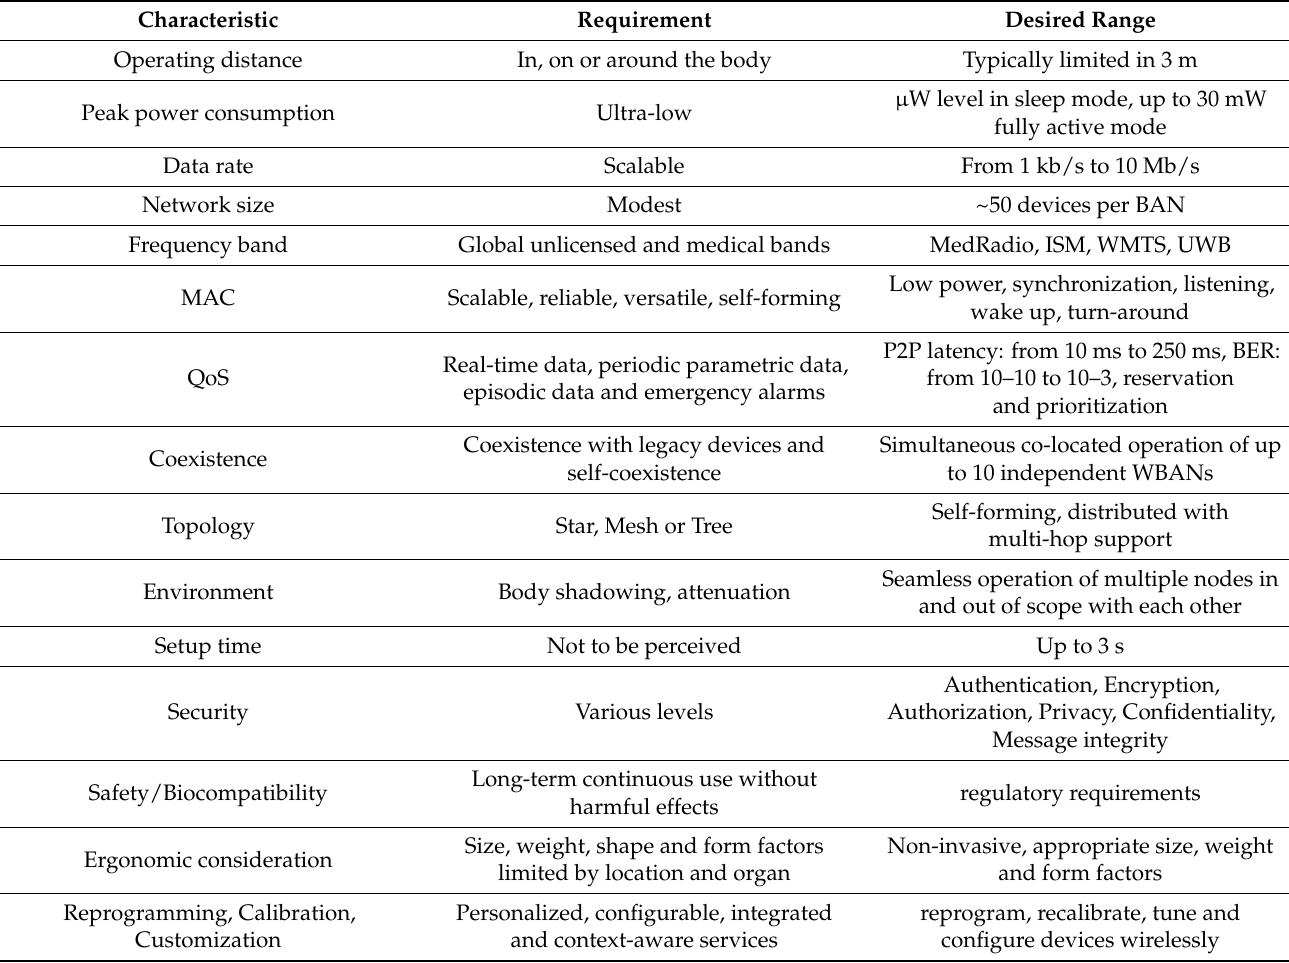
Table 4. Summary of technical requirements and their desired